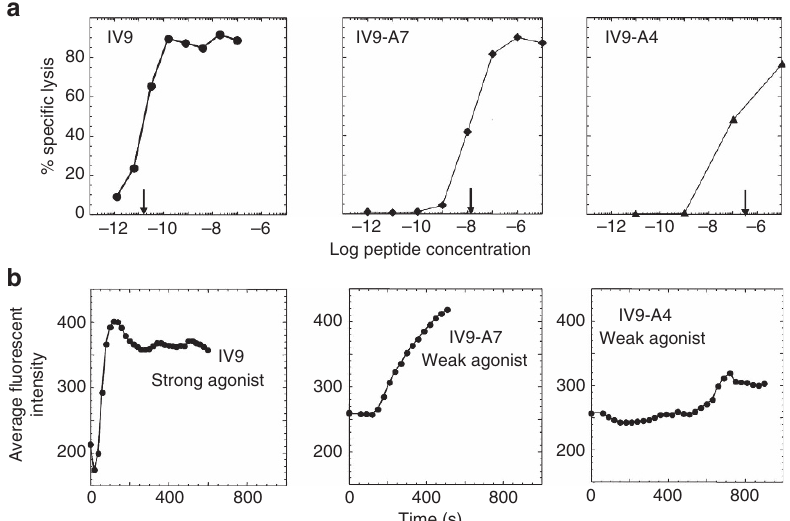
Figure 3 | Strength of stimulation influences the kinetics of Ca 2 þ signalling in CTL. ( a ) Cytotoxic activity by human 68A62 cell line against HLA-A2 þ JY target cells is shown. Differences in concentration of strong ILKEPVHGV (IV9) and weak (IV9-A7 and IV9-A4) agonist peptides that are required to achieve the same extent of specific target cells lysis by 68A62 cells are marked by arrows. ( b ) Difference in the kinetics of calcium accumulation in responding 68A62 CTL stimulated with strong (IV9) and weak (IV9-A7 and IV9-A4) agonist peptides at a high peptide concentration (10 (cid:2) 4 M) is shown. The data are representative from two to five independent experiments. The results shown on b are based on the analysis of 2,000 T